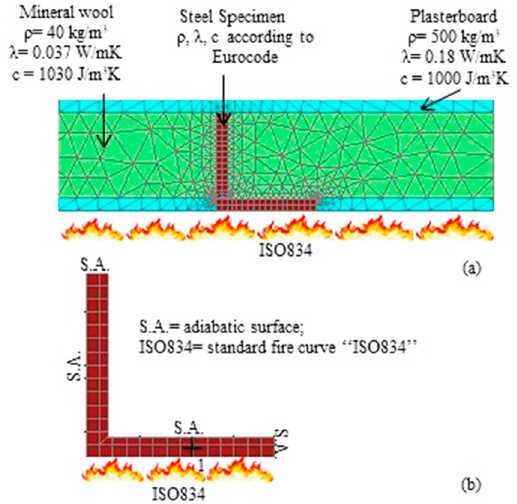
Figure 3. The tested specimen for intumescent coating ( a ) Test assembly, ( b ) The steel member